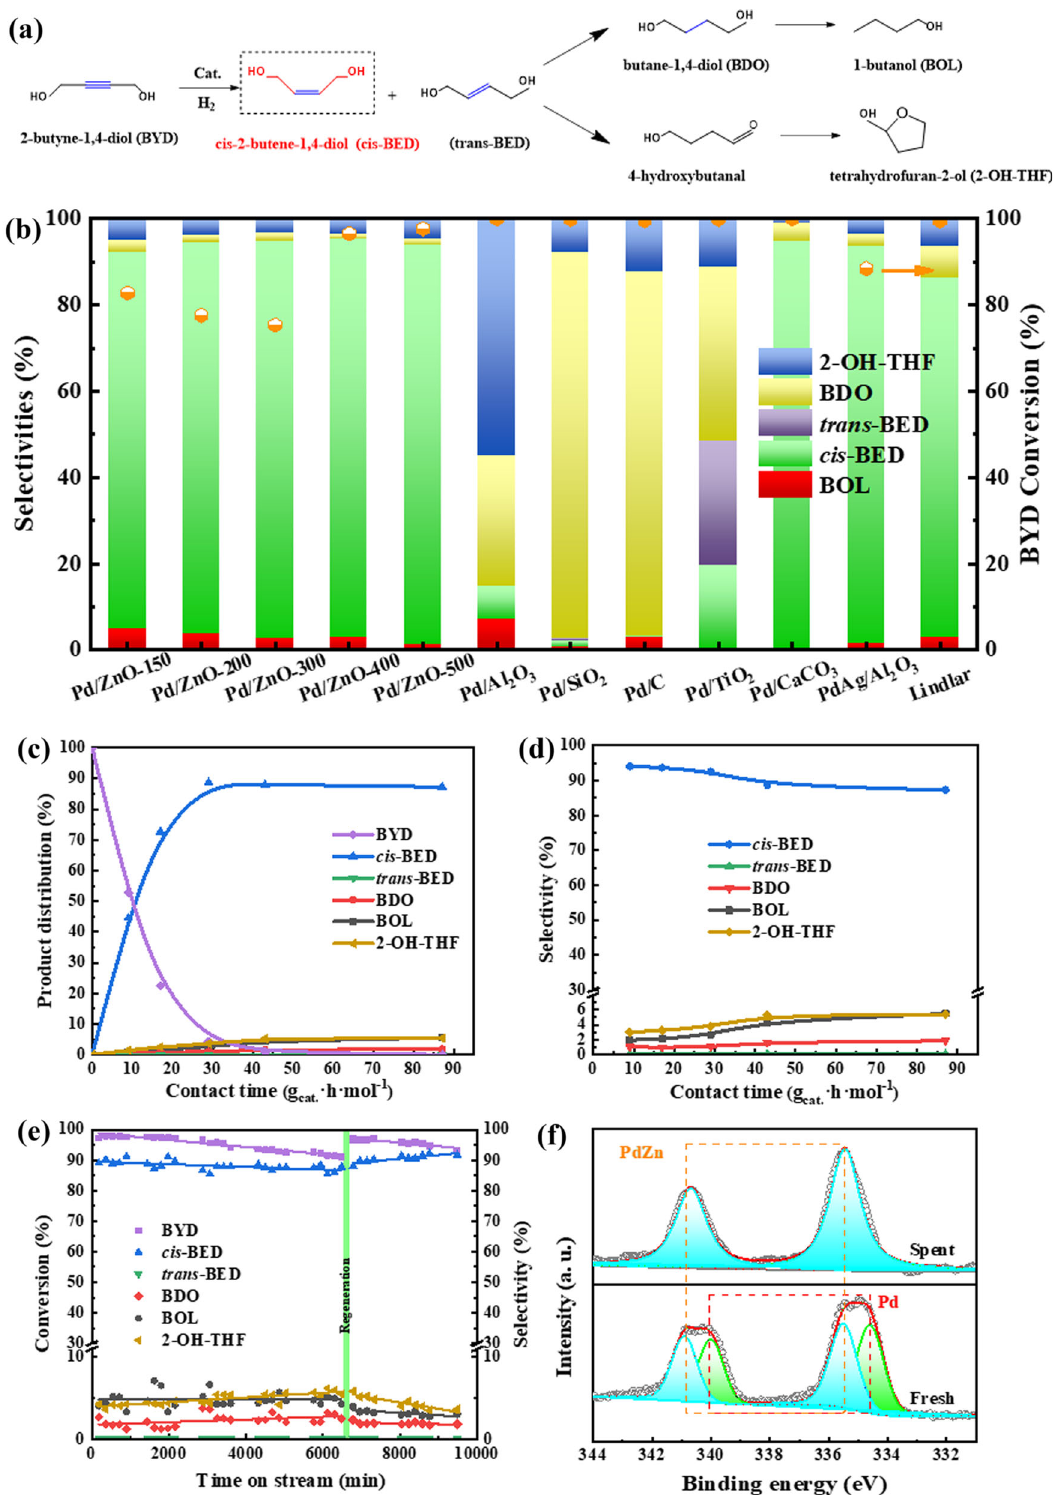
Fig. 3 Selective hydrogenation properties of catalysts. a Reaction pathway for the hydrogenation of BYD. b Conversion of BYD and product selectivity over Pd/ZnO- T catalysts and the commercial Pd-based catalysts (Reaction conditions: 2 MPa H 2 , 80 °C, and contact time 29 g cat h mol − 1 ). c , d Product distribution and selectivity of the BYD hydrogenation versus the contact time over Pd/ZnO-400 catalyst. e The stability testing of Pd/ZnO-400 catalyst in the BYD hydrogenation, in which the catalyst is regenerated at 110 h. f XPS spectra of Pd 3 d region of the fresh and spent Pd/ZnO-400 catalyst.